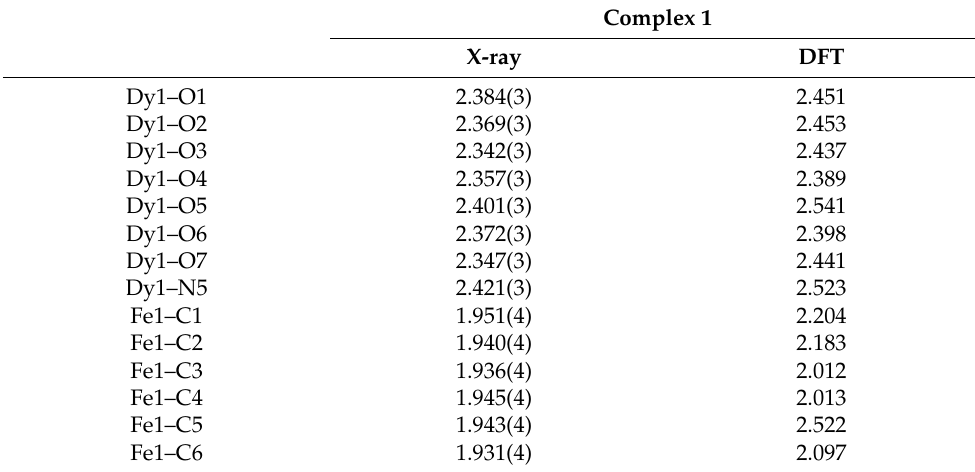
Table 2. Selected bond distances (Å) for 1 .